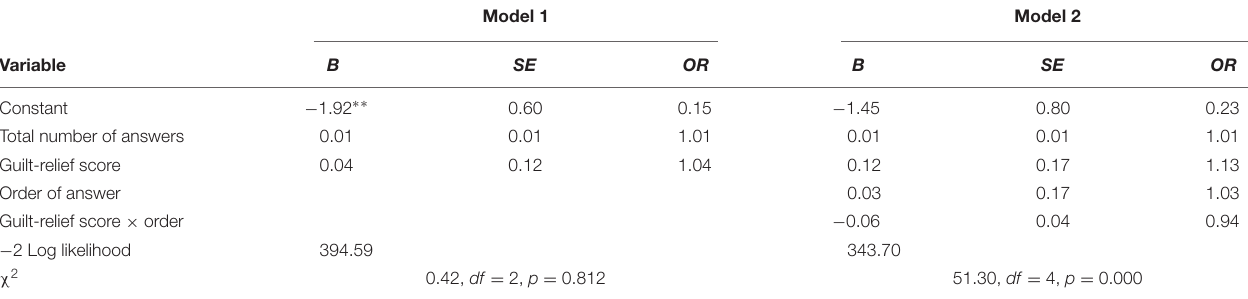
TABLE 2 | Results of logistic regression on number of thumbs-up